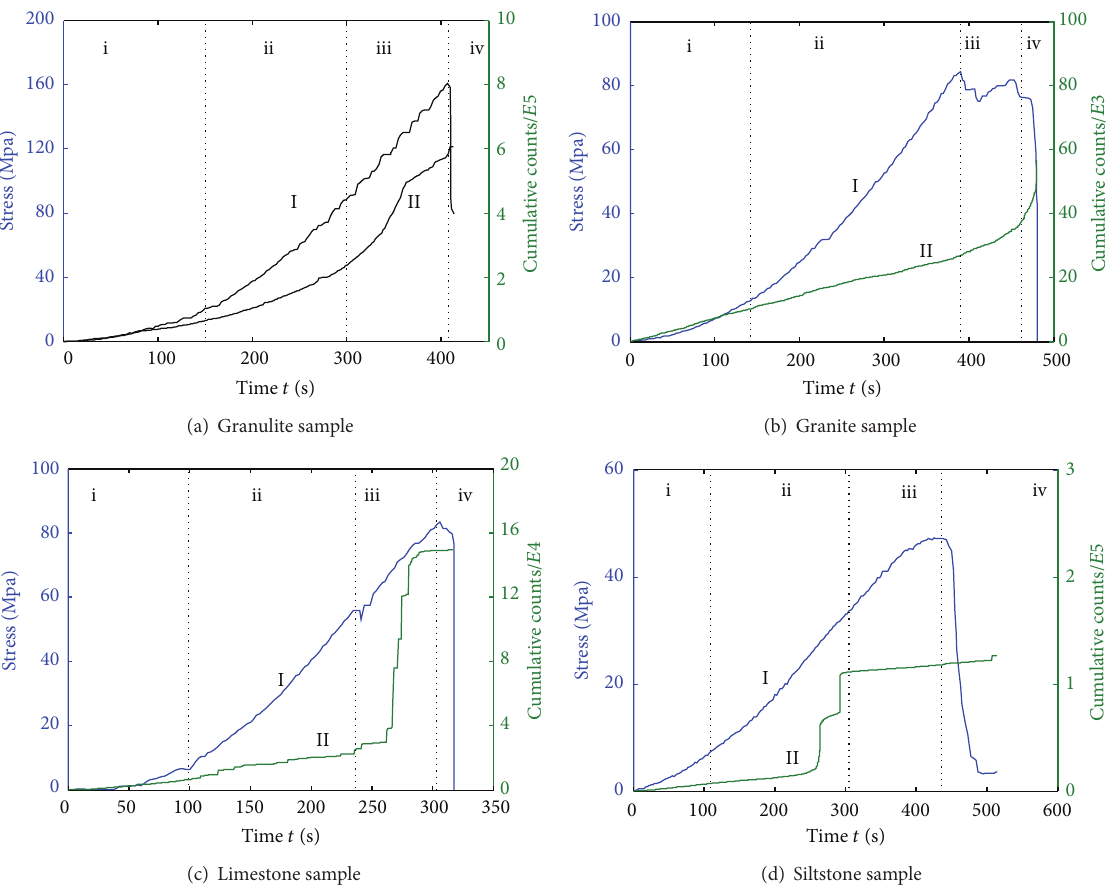
Figure 2: Curves of cumulative counts, axial stress, and load time (I: stress-time curve; II: cumulative counts-time curve).